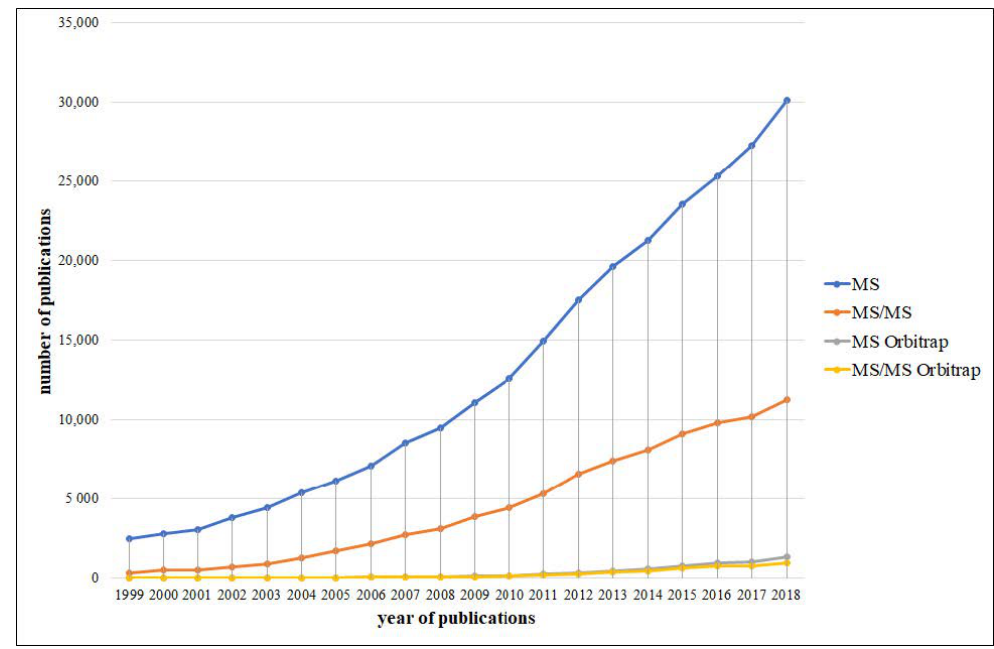
Figure 2. Evaluation of the manuscripts linked to food analysis together to (i) MS, (ii) MS/MS, (iii) MS Orbitrap, and (iv) MS/MS Orbitrap methods. The x -axis represents the year of publications, while the y -axis represents the number of publications. Data derived from the Scopus database using the search term “food analysis” coupled (using “AND” as relationship term) with “mass spectrometry”, “tandem mass spectrometry”, “mass spectrometry + Orbitrap”, and “tandem mass spectrometry + Orbitrap”, respectively. MS = mass spectrometry; MS/MS = tandem mass spectrometry.